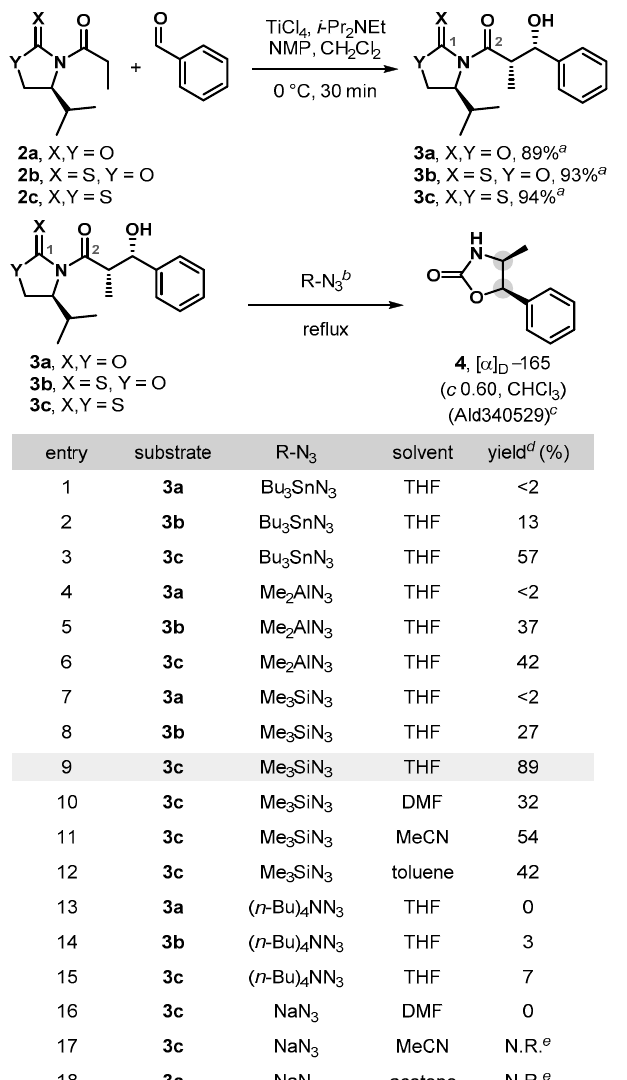
Scheme 2. Synthesis of oxazolidin-2-one via the azidation/Curtius rearrangement sequence. a